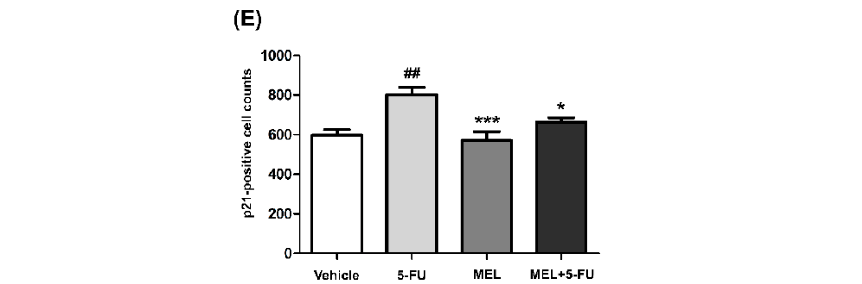
Figure 2. Immunofluorescence staining of a cell cycle arrest. Green p21-positive cells are indicated with arrowheads in the SGZ of the dentate gyrus ( A – D ). Sections were counterstained with red nuclear dye, propidium iodide (PI). Inserted images show p21 immunofluorescence staining under high magnification (Bar scales: 50 µ m, 40 × ). The number of p21-positive cells in the 5-FU group was significantly higher than those in the vehicle group ( E ). ## p < 0.01 compared with the vehicle group. * p < 0.05, *** p < 0.001 compared with the 5-FU group. Subgranular zone: SGZ; granule cell layer: GCL; molecular layer: ML.